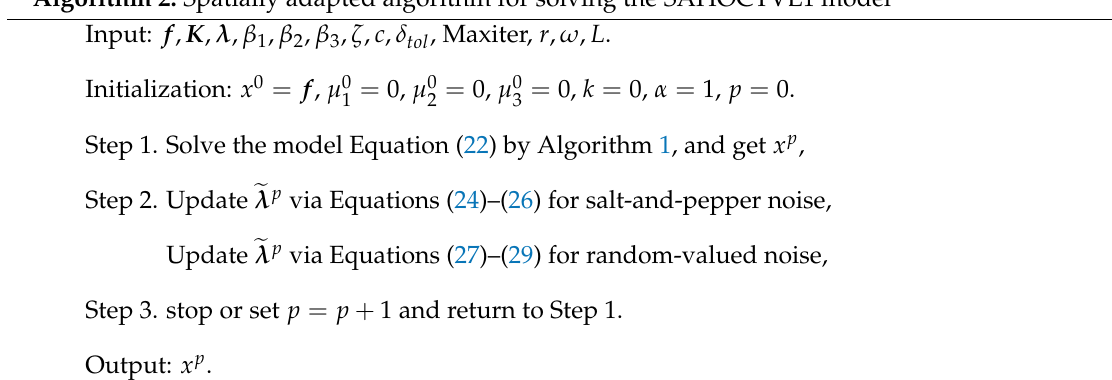
Algorithm 2: Spatially adapted algorithm for solving the SAHOCTVL1 model